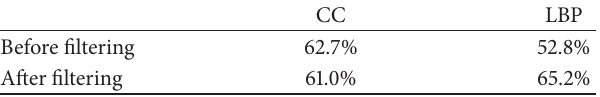
Table 3: Average precision rates before and after filtering.